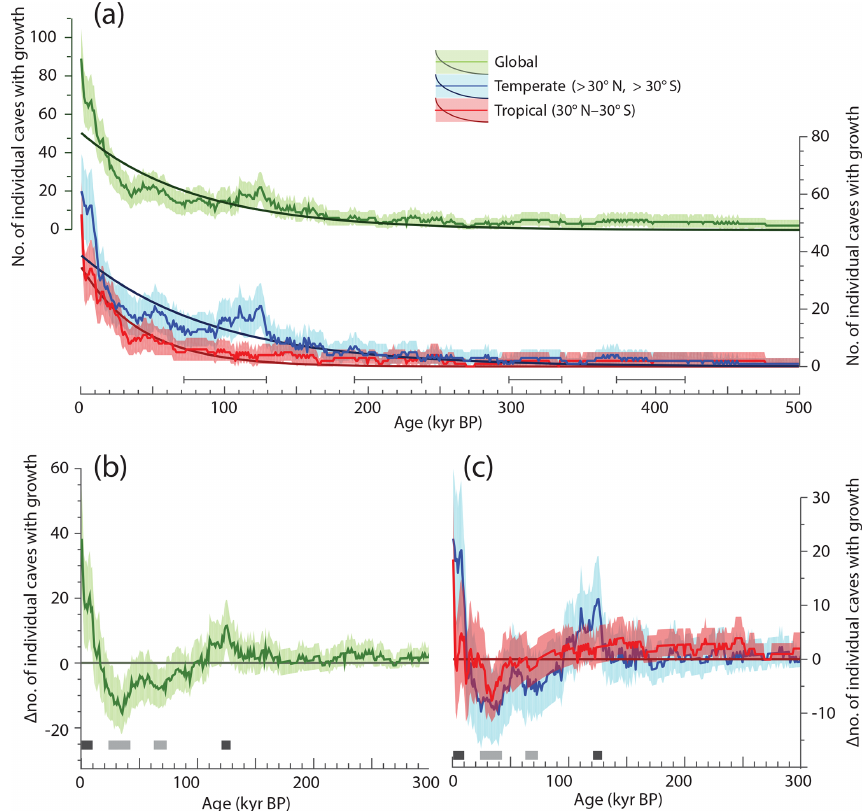
Figure 2. Distribution of the number of single caves with speleothem growth through time. (a) Number of single caves with growth over the last 500000 yrBP (where present is 1950CE) in 1000-year bins (solid line), bootstrapped estimate of uncertainty (shading between 5% and 95% percentiles) and fitted exponential distribution (darker solid line). Horizontal bars denote previous interglacials. (b, c) Same as (a) but with the fitted exponential distribution subtracted to highlight anomalies from the expected number of caves over the last 300kyrBP. Horizontal bars indicate periods with significantly greater (dark grey) or fewer (light grey) numbers of caves with speleothem growth than expected. Green indicates the full global dataset; blue and red indicate temperate and tropical subdivisions